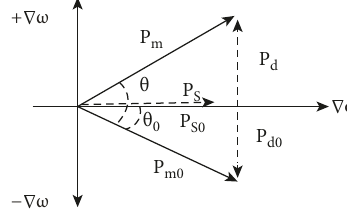
Figure 4: Phasor diagram of governor